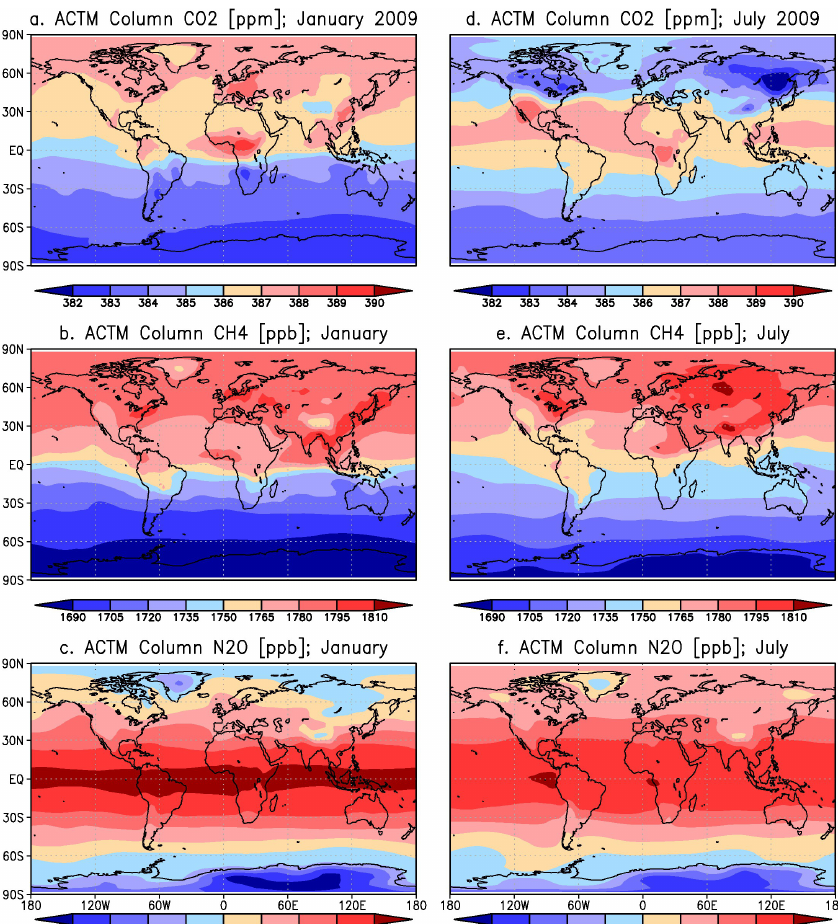
Fig. 2. Monthly mean global distributions of the ACTM-simulated total column CO 2 , CH 4 and N 2 O (without applying averaging kernel and a priori smoothing) in January (left column) and July (right column) 2009.